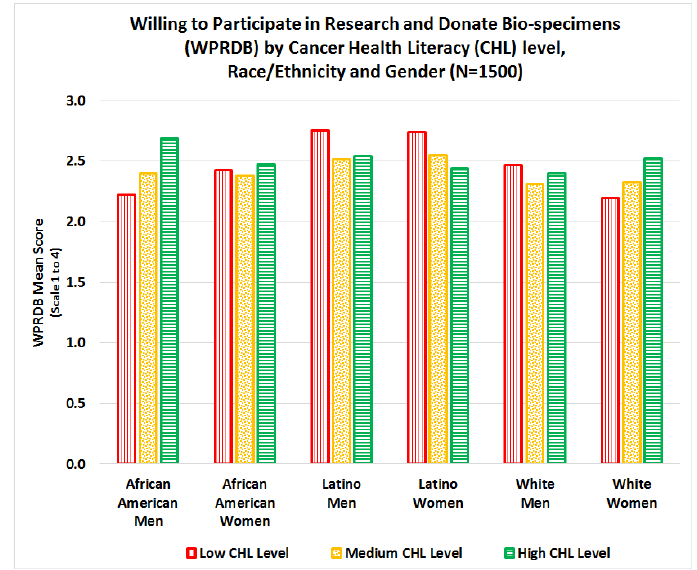
Figure 9. Interaction between cancer health literacy, race/ethnicity, and gender on WPRDB total scale.